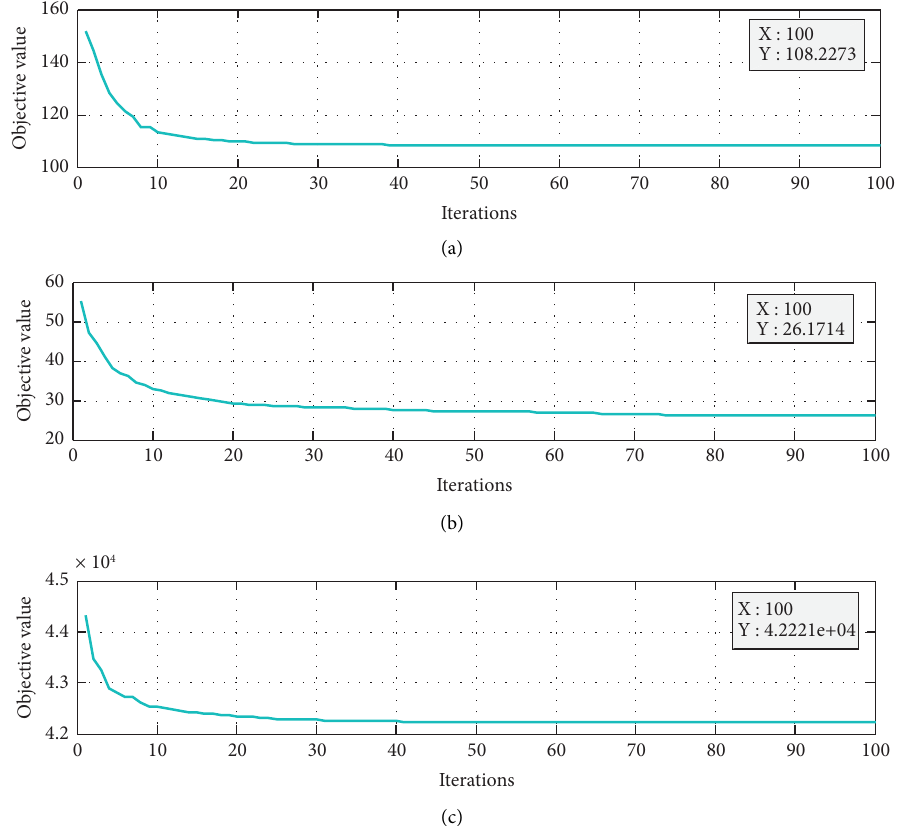
Figure 13: Convergence characteristic curves for new biobjective and triobjective OPF (Case 26 through Case 28) of the IEEE 57-bus system: (a) Case 26; (b) Case 27; (c) Case 28. Table 13: Optimal solutions obtained by BSOA for all cases (Case 29 to Case 31) of the IEEE 118-bus system. Cases